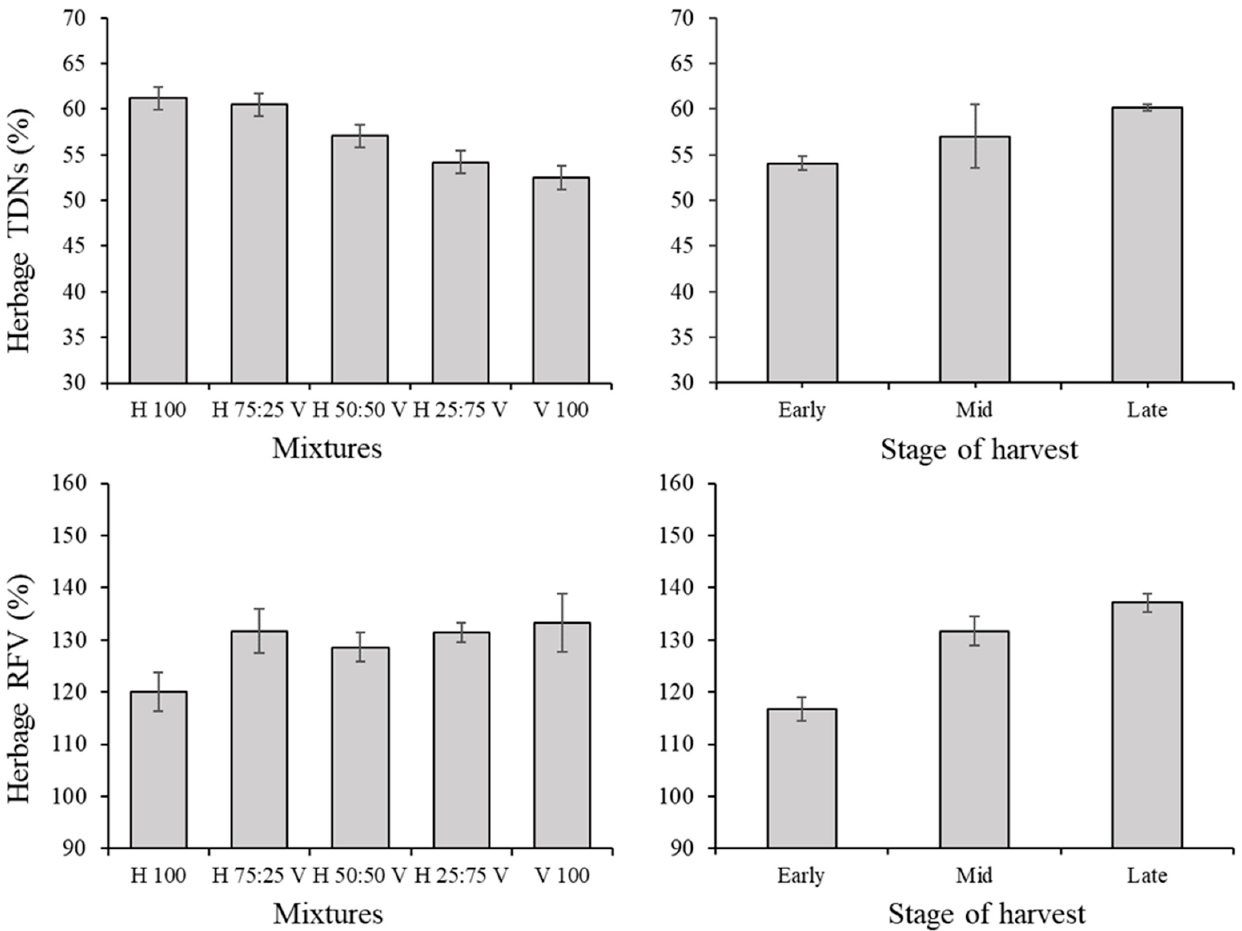
Figure 6. Herbage TDN concentration ( above ) and RFV ( below ) as affected by MX ( left ) and SH ( right ) mean effect. Values are LSmeans across all treatments along with standard error estimate of the LSmeans since the design was unbalanced between the faba bean crop ( n = 9) compared to the mixtures and the barley crops ( n = 18).